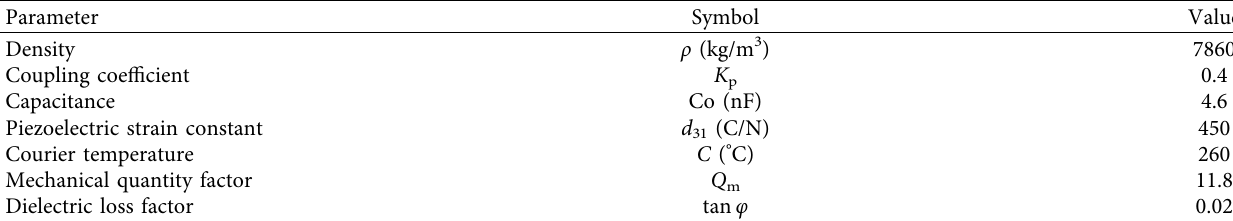
Table 2: Key properties of the PZT sensor.